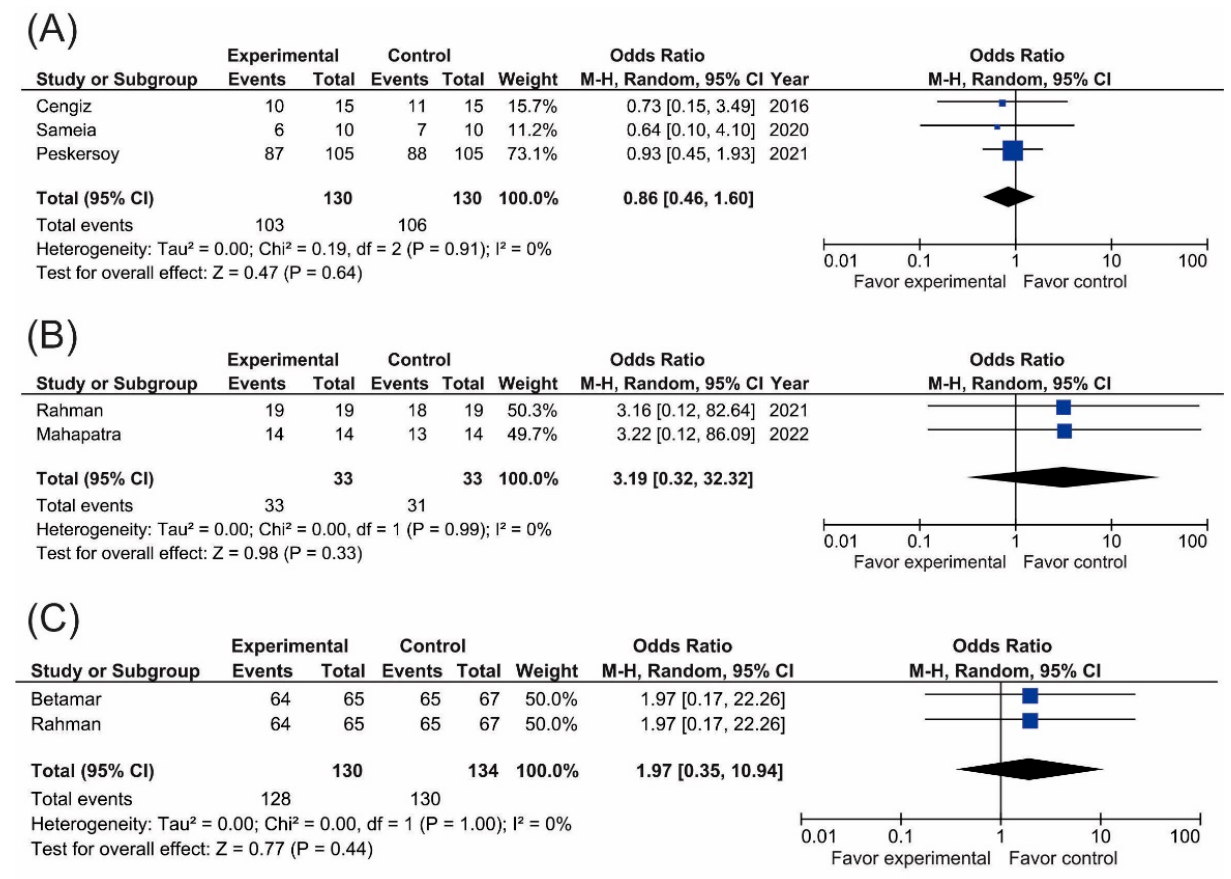
Figure 3. Meta-analysis. Forest plots of clinical success of light-cured calcium silicate based-material (TheraCal LC); ( A ) Direct pulp capping in permanent teeth at 6 months, ( B ) Indirect pulp capping in permanent teeth at 6 months, and ( C ) Indirect pulp capping in permanent teeth at 12 months.